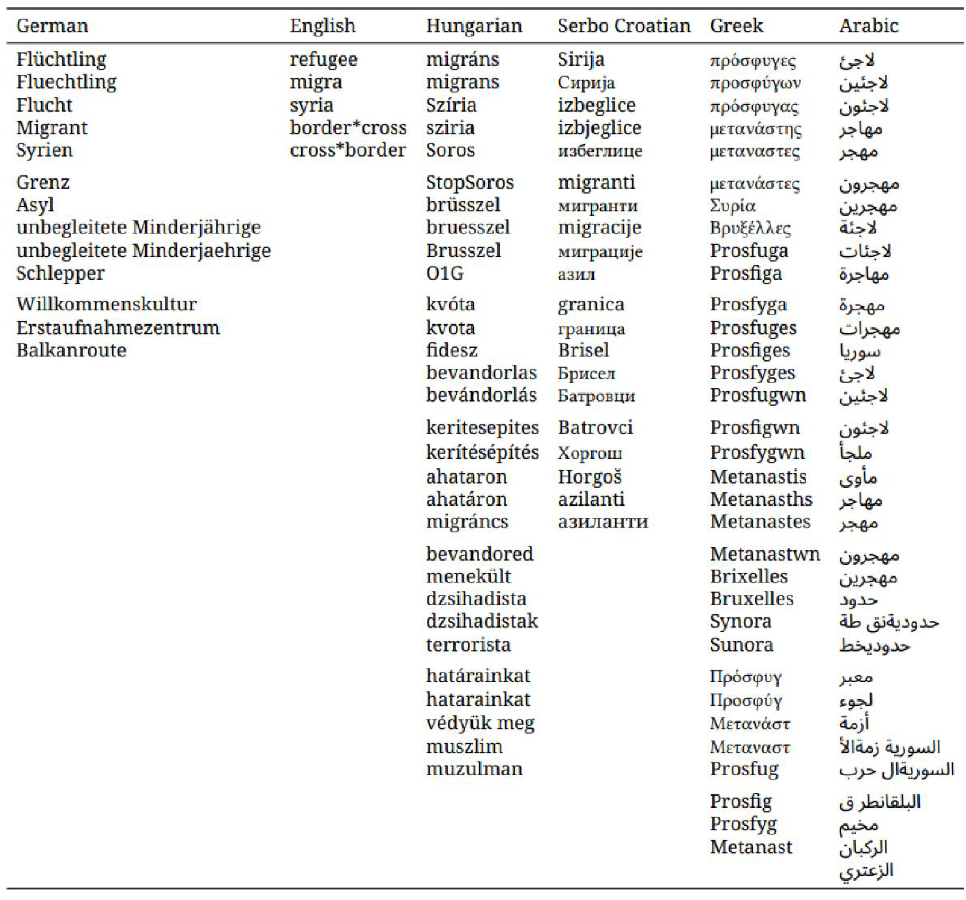
Figure 6. Refugee-related keywords in German, English, Hungarian, Serbo-Croatian, Greek and Arabic.